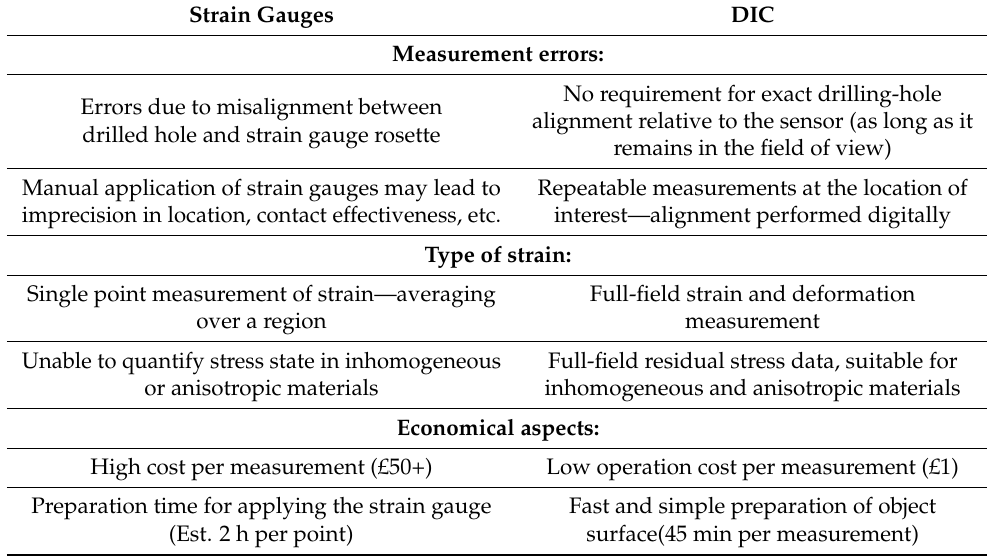
Table 1. Benefits of using DIC over strain gauges for strain relief quantification. Strain